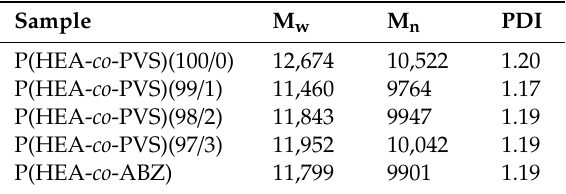
Table 1. The molecular weight of copolymers.